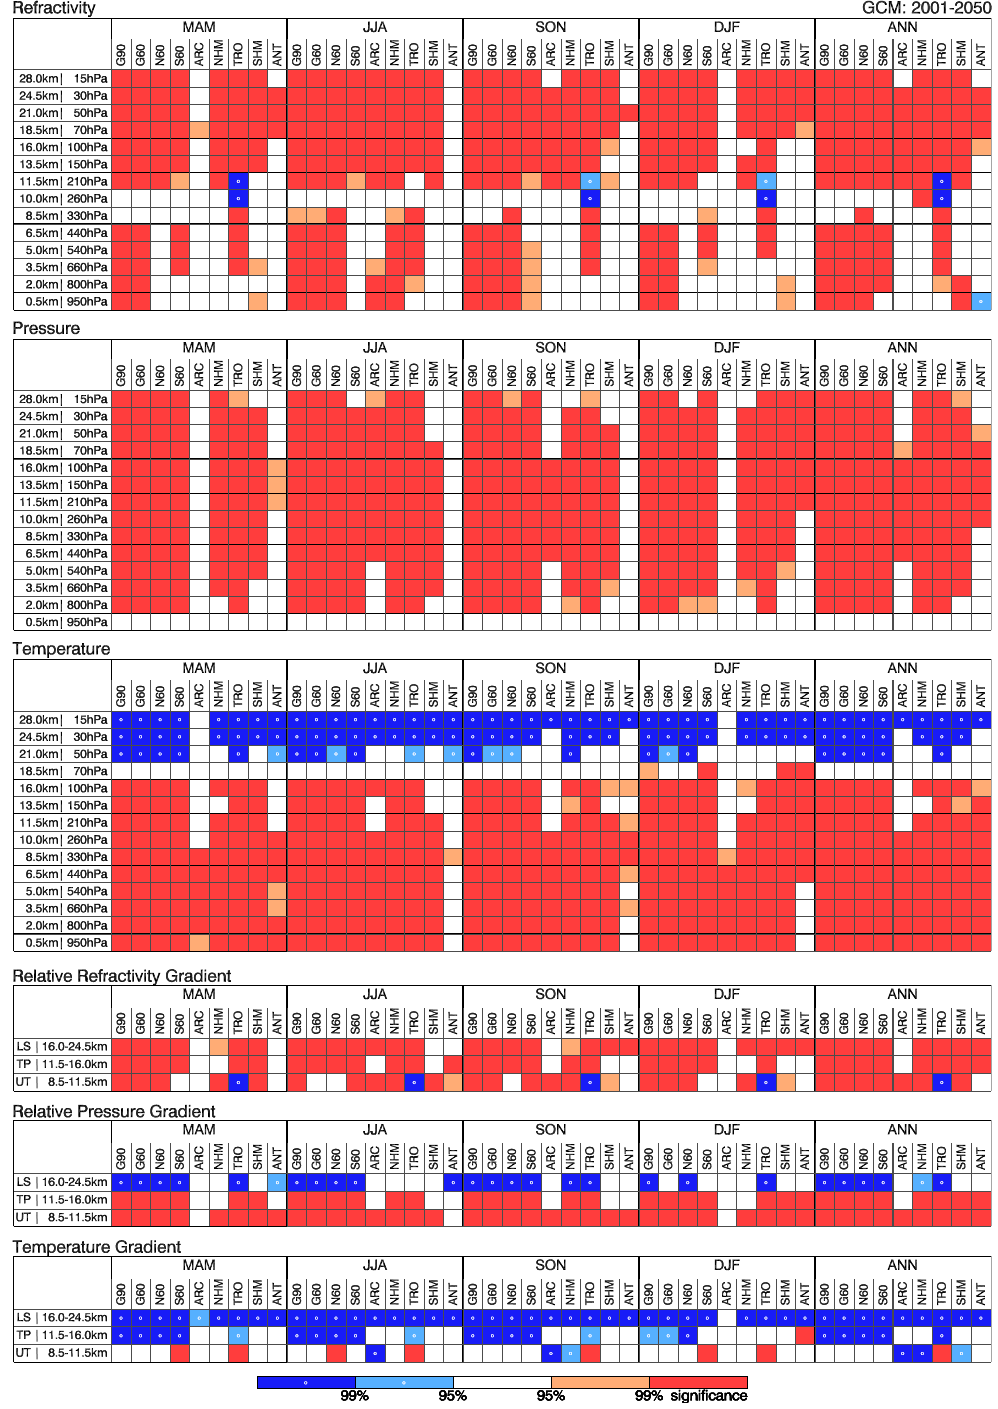
Fig. 7. Trend indicators based on 10 selected GCM simulations for the period 2001 to 2050 for the RO-accessible variables refractivity, pressure, temperature, relative refractivity gradient, relative pressure gradient, and temperature gradient (from top to bottom). Results are shown for large-scale zonal means (as defined in Fig. 3) at all investigated height levels and layers, for all seasons and for the annual mean (left to right). Positive trends are red coloured, negative trends in blue. Trend significances greater than 99% are marked by dark colours, significances greater than 95% by light